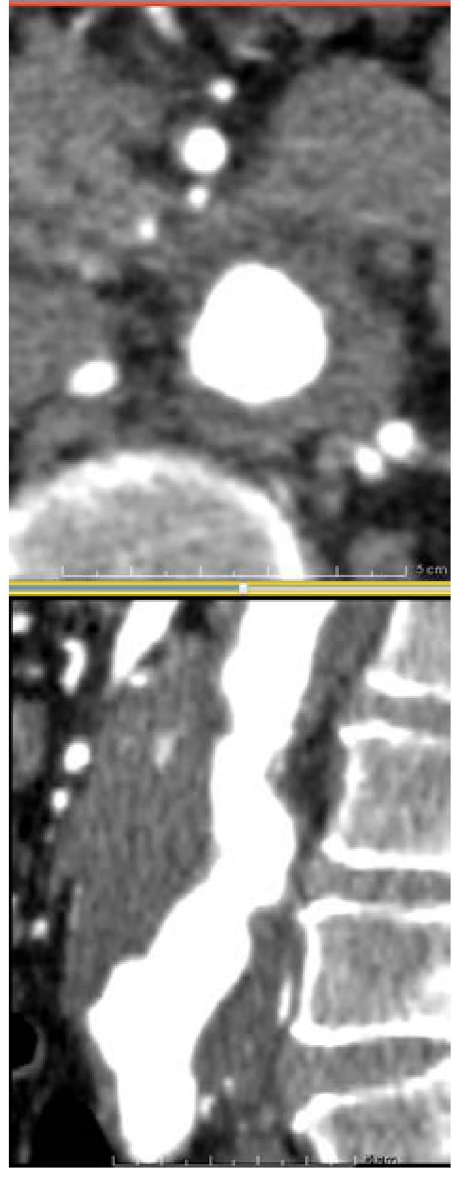
Figure 3. Case 2 used in reproducibility analysis. Axial (top) and sagittal (bottom) CT slices of the AAA. The poor contrast between the AAA and surrounding organs makes segmentation very